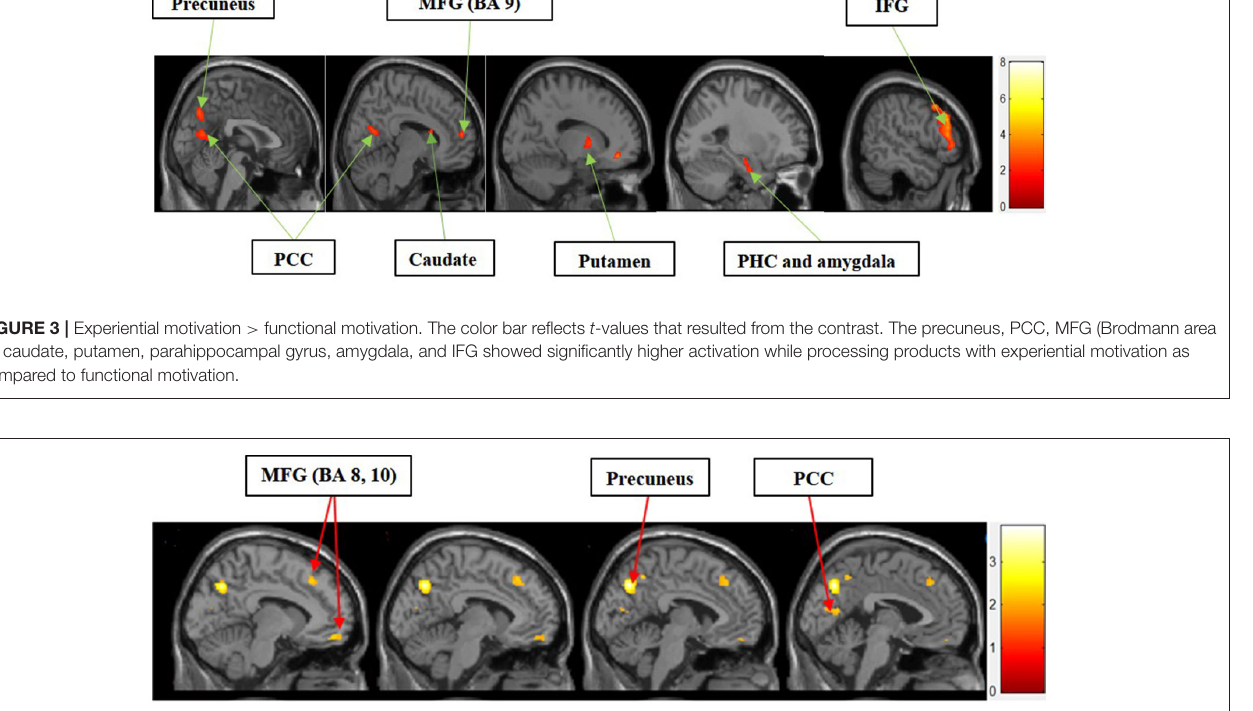
FIGURE 4 | Symbolic motivation > functional motivation. The color bar reflects t -values that resulted from the contrast. The MFG (Brodmann areas 8, 10), precuneus, and PCC showed significantly higher activation while processing products with symbolic motivation as compared to functional motivation.